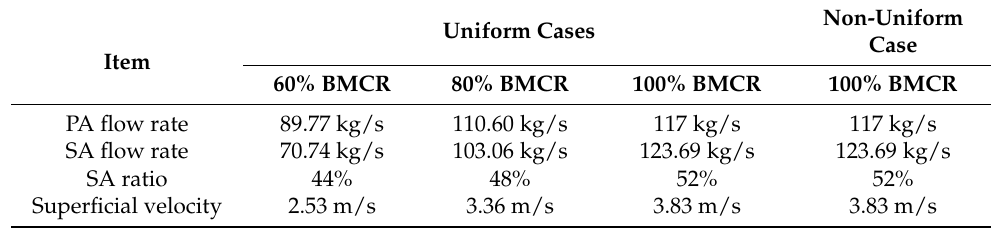
Table 2. PA and SA flow rate at each case.